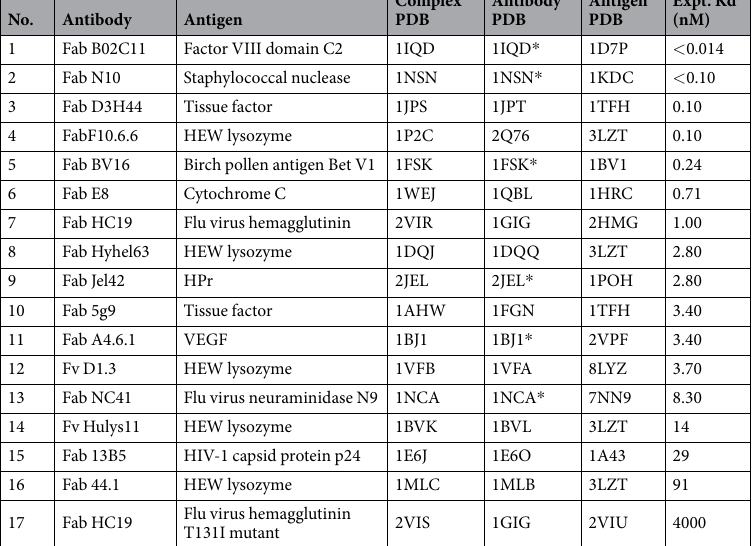
Antibodies constitute the most important class of therapeutic biologics. Accurate binding estimates can aid development of in silico screening methods to pick a potential list of epitope-diverse antibodies during animal immunization NGS campaigns, and help design better-behaving therapeutic antibodies with minimal off-target activity. Unfortunately, estimation of absolute binding free energies for antibody–antigen complexes is chal- lenging due to the inaccuracies in the computational free energy calculations. Additionally, since all antibodies share the immunoglobulin fold with sequence variability primarily in the complementarity determining regions (CDRs), domain or sequence-similarity based binding predictors are not reliable. So accurate biophysics-based cross-docking methods aimed at identifying potential antibody–antigen interaction partners are of immense value. Previous cross-docking attempts 15, 16 on a dataset of diverse protein–protein complexes found the predic- tion of antibody–antigen interaction pairs to be especially difficult. In this paper, we present a cross-docking study to discriminate antibody–antigen binders from non-binders using a dataset of 17 complexes with both bound and unbound antigen structures available. We first generate a dataset of cognate and non-cognate complexes and test the RosettaDock score function for identification of the correct antibody–antigen interaction partners. We evaluate the effects of antibody backbone accuracy on the partner predictions using antibody bound, unbound structures, and RosettaAntibody 17 generated homology